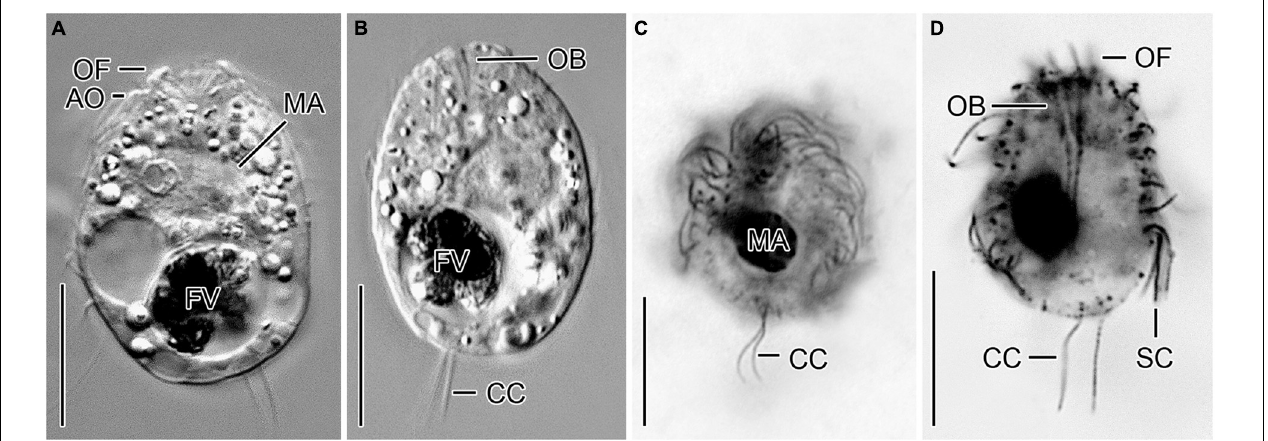
FIGURE 3 | Urotricha furcata , specimens of strains CIL-2019/13 in vivo (A,B) as well as of the non-clonal original culture (C) and CIL-2019/6 (D) after protargol staining from Lake Zurich. (A,B,D) Optical longitudinal sections. (C) Oblique posterior polar view. AO, adoral organelles; CC, caudal cilia; FV, food vacuole; MA, macronucleus; OB, oral basket; OF, oral flaps; SC, somatic cilia. Scale bars 10 µ